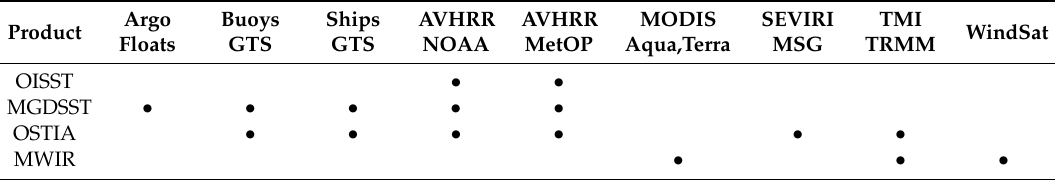
Table 2. Instruments and sensors used to produce the global gridded SST